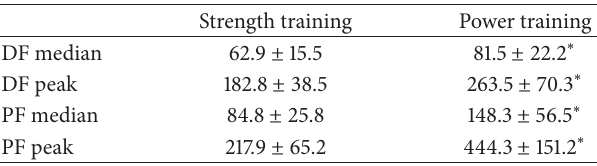
Table 2: Velocities (degrees/second) during dorsiflexor (DF) and plantar flexor (PF) strength and power